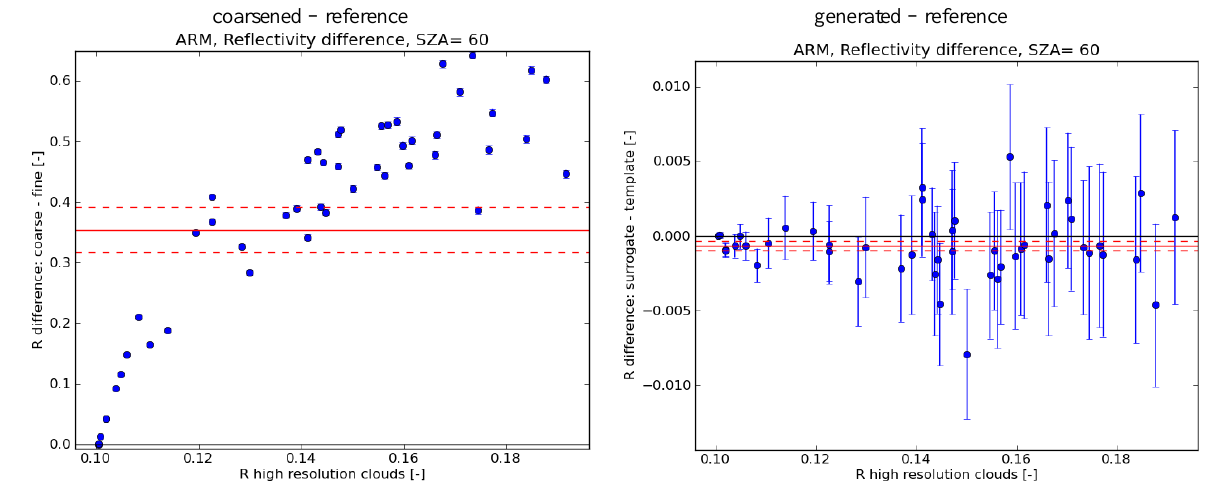
Fig. 7. Same as Fig. 6 but for a solar zenith angle of 60 ◦ .